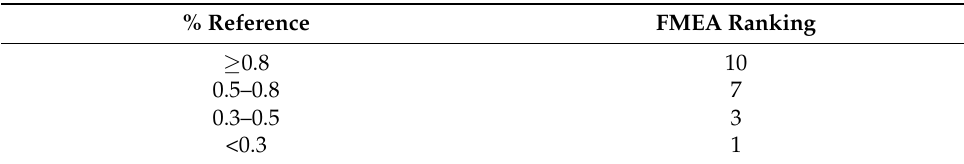
Table 2. FMEA ranking algorithm.